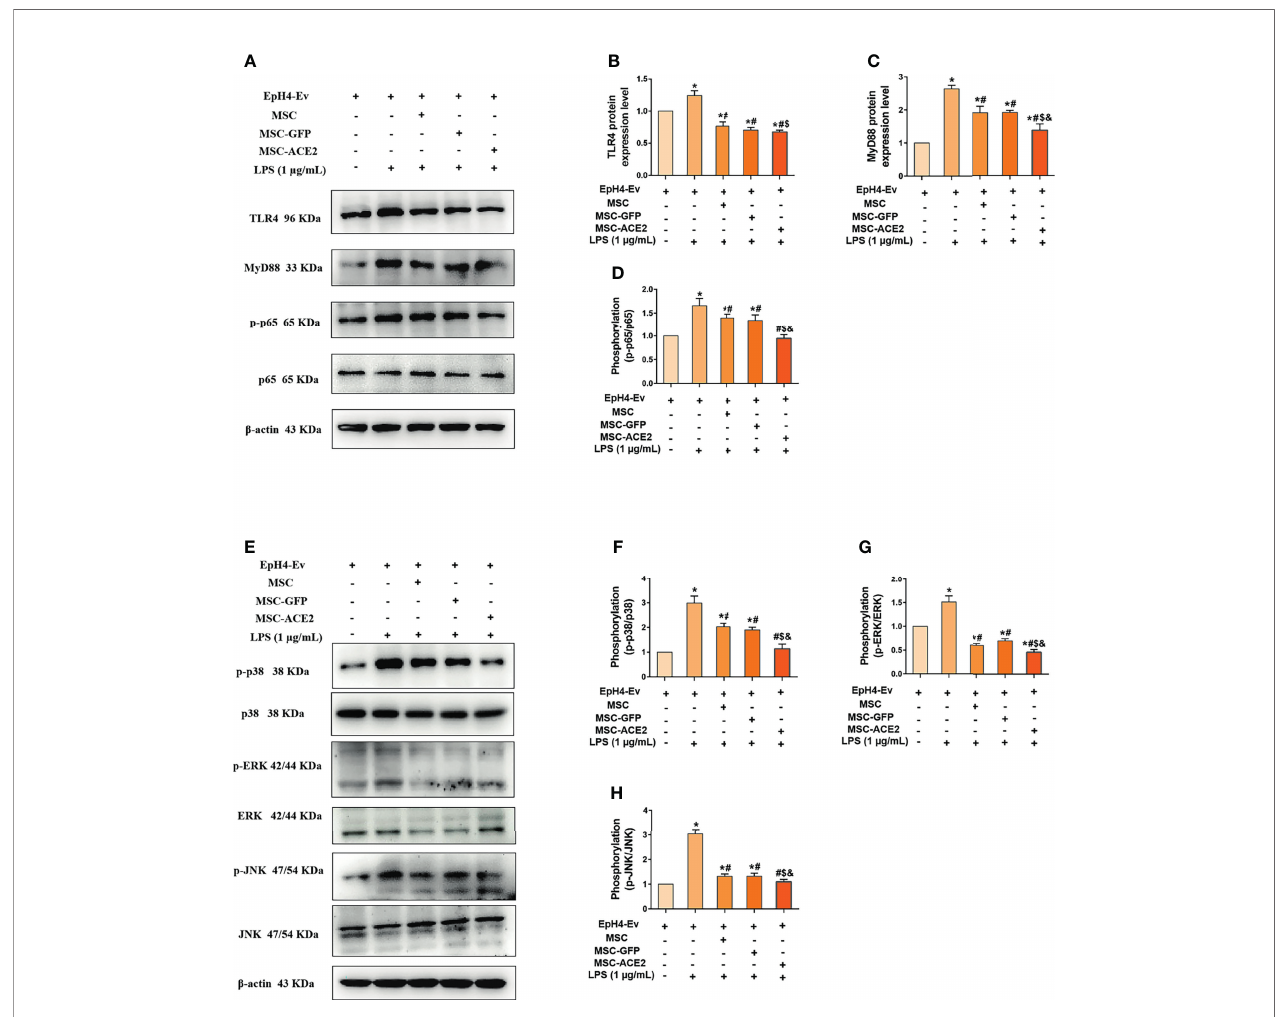
FIGURE 6 | MSC-ACE2 downregulates TLR4/MAPK/NF- k B signaling pathway activation to inhibit LPS-induced in fl ammation in EpH4-Ev cells. (A) Detection of relative protein expression levels of TLR4, MyD88, p65 and phosphorylation levels of p65 by Western blot; (B – D) Statistics of TLR4, MyD88, p65 and phosphorylation levels of p65 proteins Western blot results; (E) Detection of relative protein expression levels of phosphorylation levels of p38, ERK, JNK, and p38, ERK, JNK by Western blot; (F – H) , Statistics of phosphorylation levels of p38, ERK, JNK, and p38, ERK, JNK Western blot results. Experiments were repeated three times and data were presented as the mean ± SEM (n = 4). * P < 0.05 vs. EpH4-Ev; # P < 0.05 vs. LPS; $ P < 0.05 vs. MSC; & P < 0.05 vs.